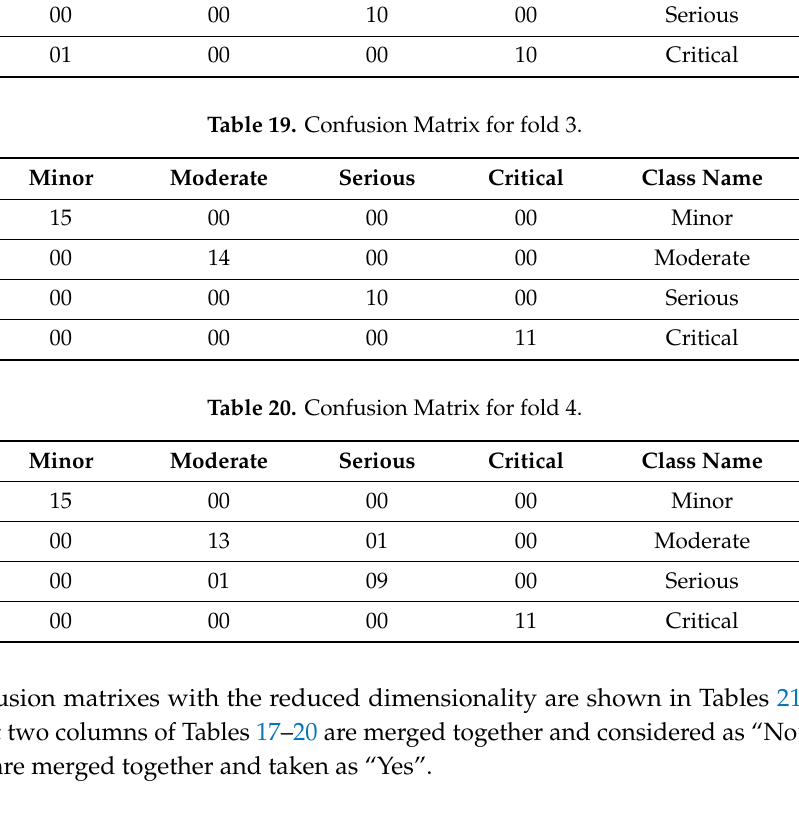
Table 21. Matrix with reduced dimensions for fold 1.